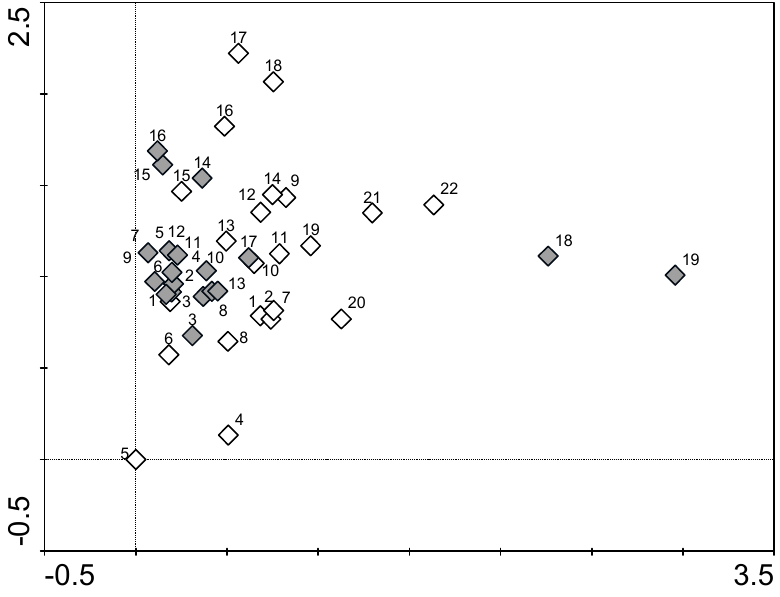
Figure 4. DCA plot showing the clustering of locations along the river flow based on different macrophyte species’ presence and abundance. White diamonds—2004, grey diamonds—2019.